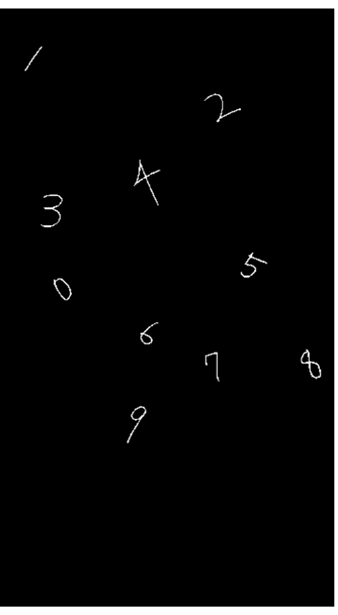
Figure 4. Sample image of digit extraction.